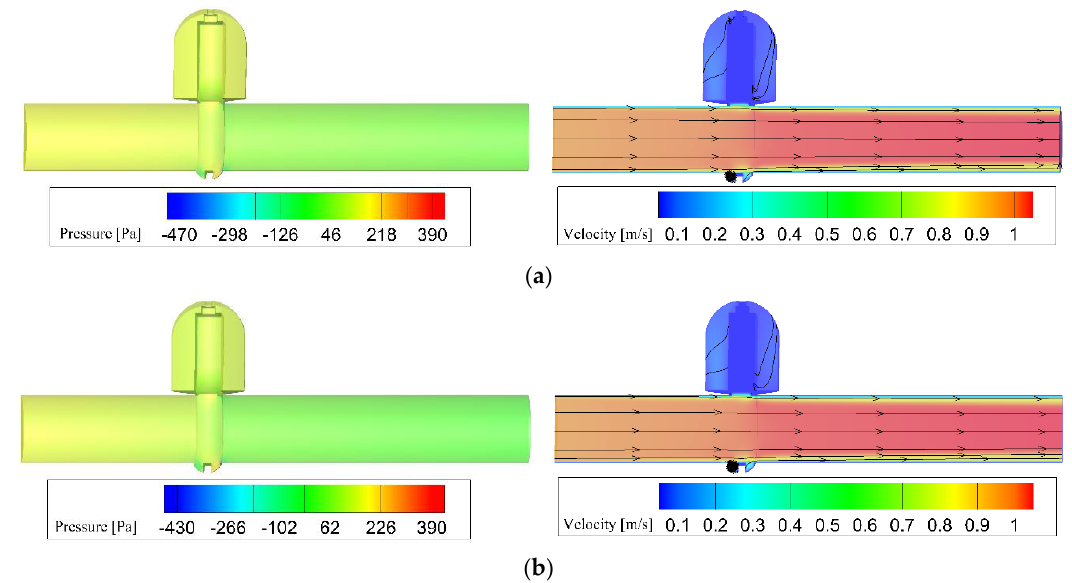
Figure 12. Pressure and flow fields under different groove depth: ( a ) Groove depth 1; and, ( b ) Groove depth 2.